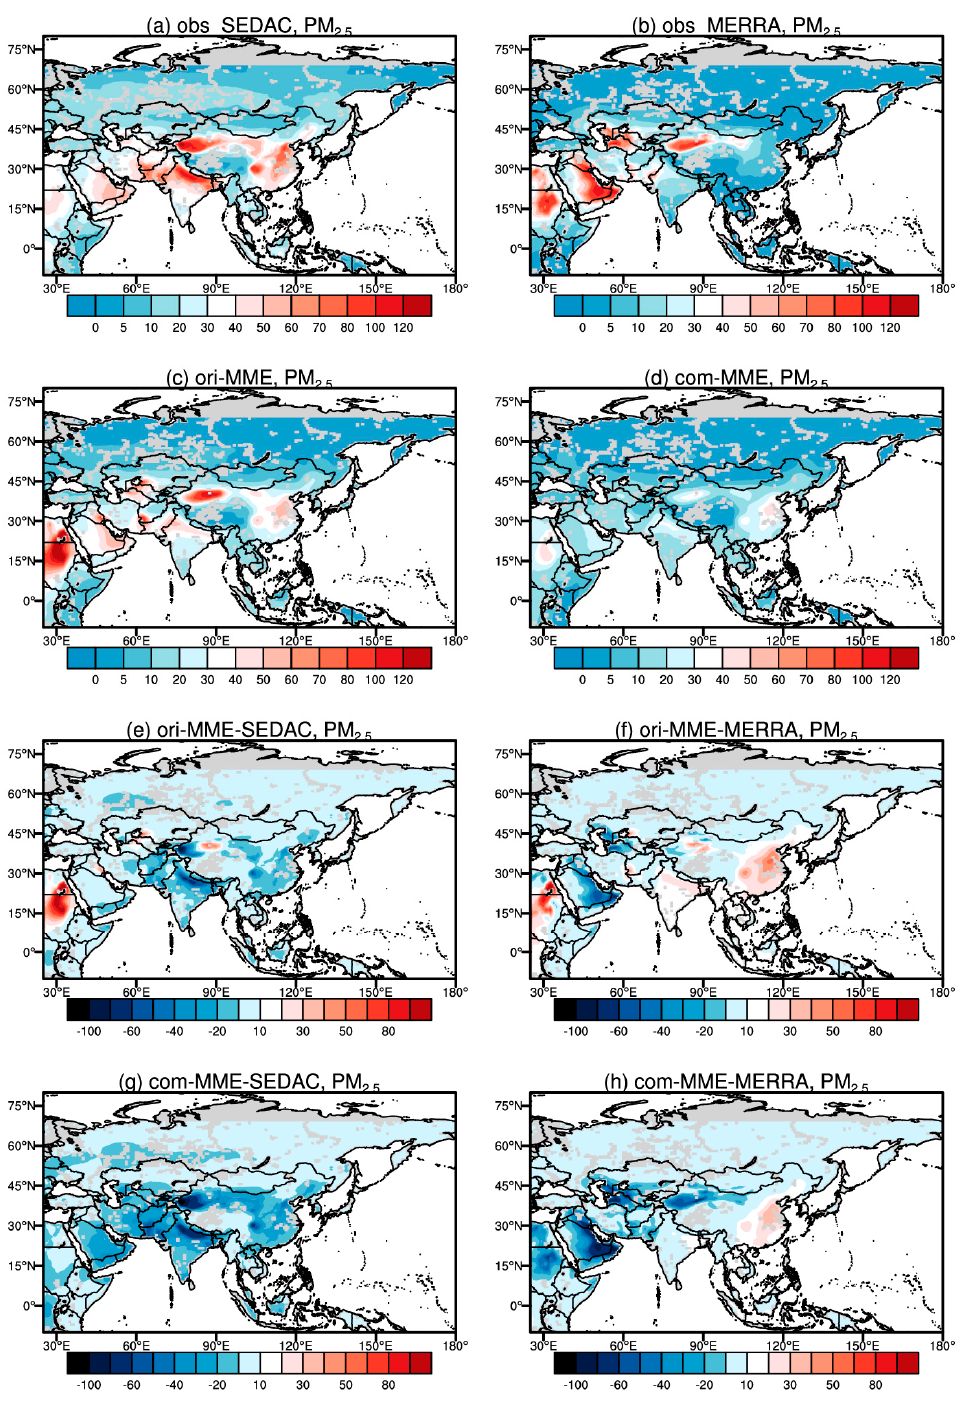
Figure 1. Spatial distribution of annual mean surface PM 2.5 concentrations (units: µg/m 3 ) during 1998–2014 from the ensemble mean of models and their biases. Figure 2 provides the model spread of original simulated surface PM 2.5